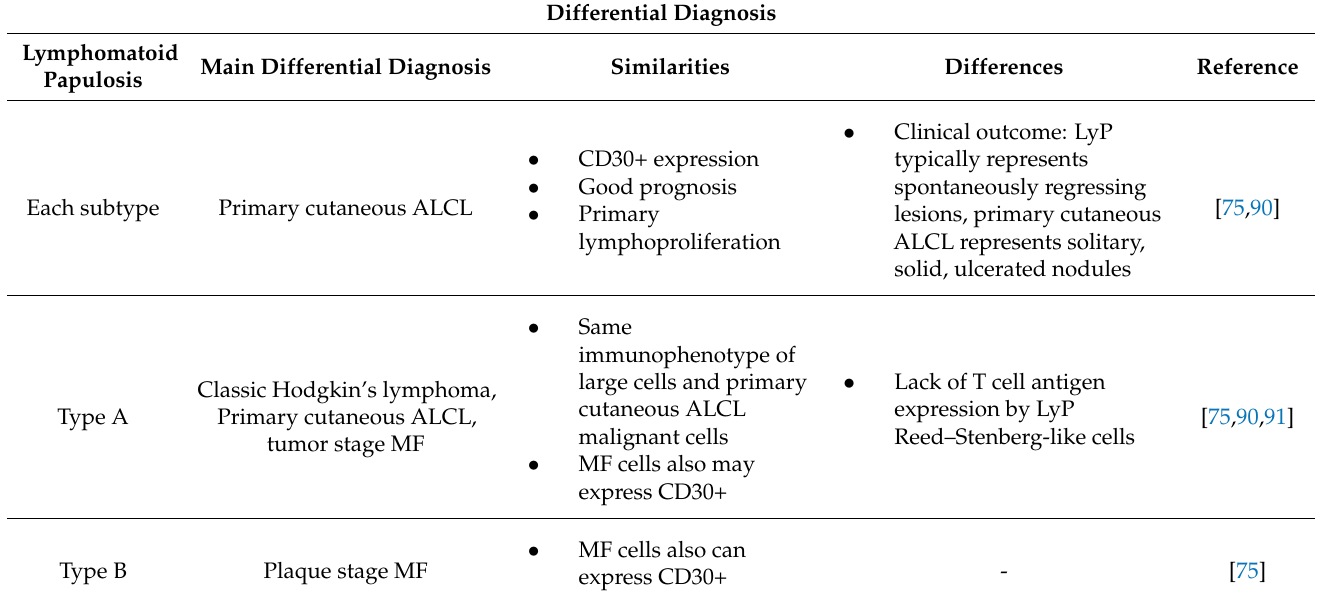
Table 2. Possible differential diagnoses of lymphomatoid